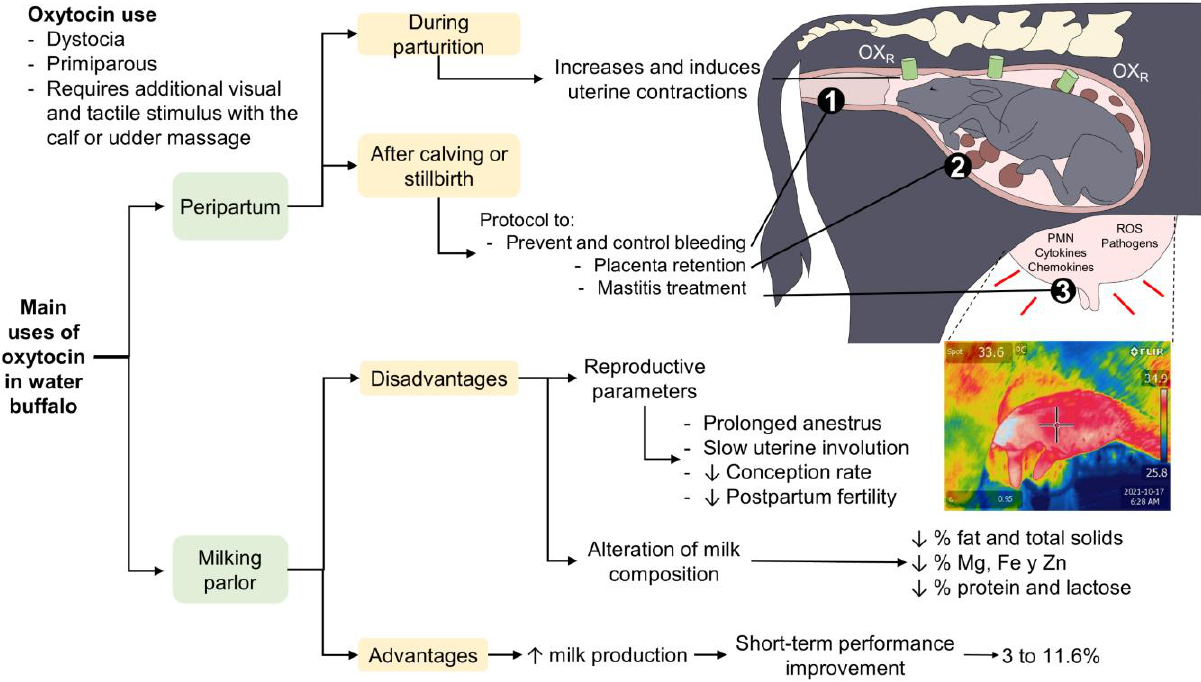
Figure 7. Positive and negative effects of oxytocin on buffalo milk production as reported in various studies as well as its principal uses as a tool during and after birth and in the milking process, with impacts on the characteristics of the composition of milk and its production. For example, mastitis processes can be detected with the help of non-invasive tools such as infrared thermography devices that can detect changes in the superficial temperature due to the inflammatory process of the MG.